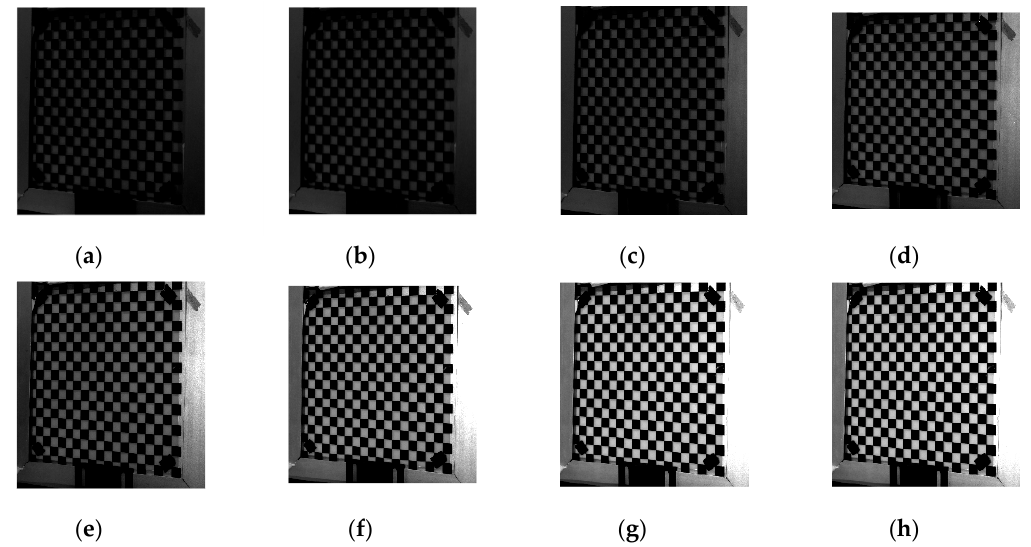
Figure 6. Checkerboard images captured by the left camera with different projection illumination. ( a ) With intensity of 0, ( b ) with intensity of 20, ( c ) with intensity of 40, ( d ) with intensity of 60, ( e ) with intensity of 80, ( f ) with intensity of 100, ( g ) with intensity of 120, ( h ) with intensity of 125.